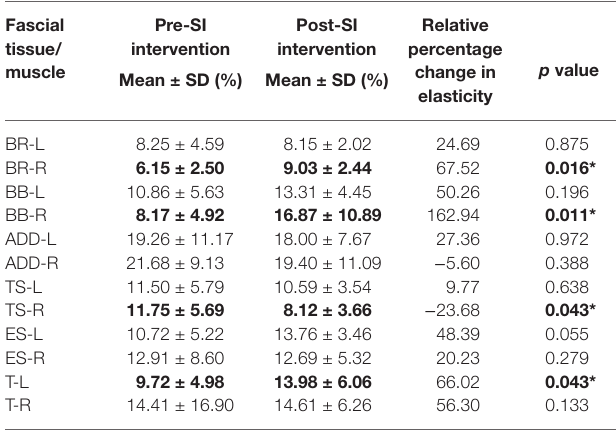
BR-L and BR-R, left and right musculus brachio-radialis; BB-L and BB-R, left and right musculus biceps-brachii; ADD-L and ADD-R, left and right adductores; TS-L and TS-R, left and right musculus triceps surae; ES-L and ES-R, left and right musculus erector spinae; T-L and T-R, left and right musculus trapezius. * and bold values means: statistical significant p <